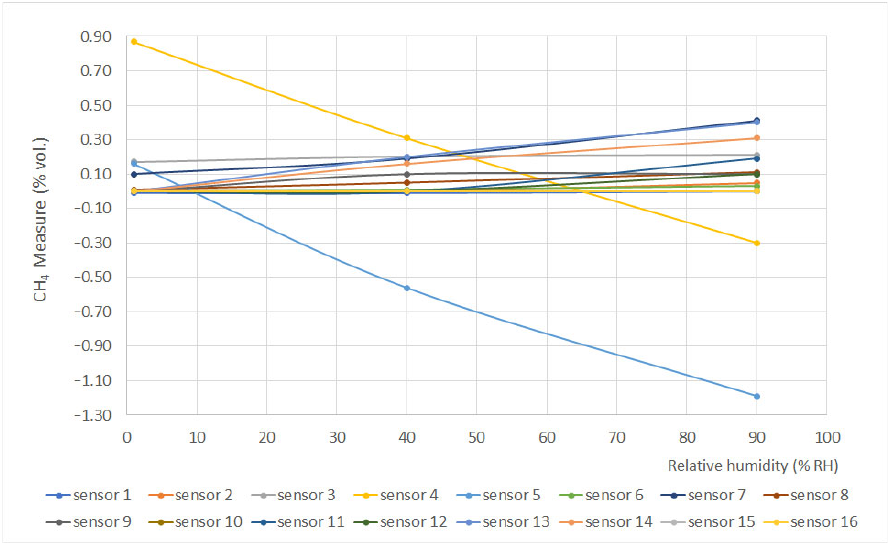
Figure 8. Humidity curves for 0% vol.